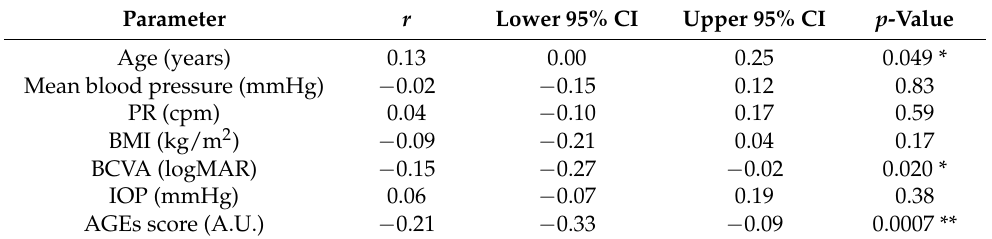
Table 5. Possible associations between the Veggie score (O.D.) and various continuous parameters. Parameter